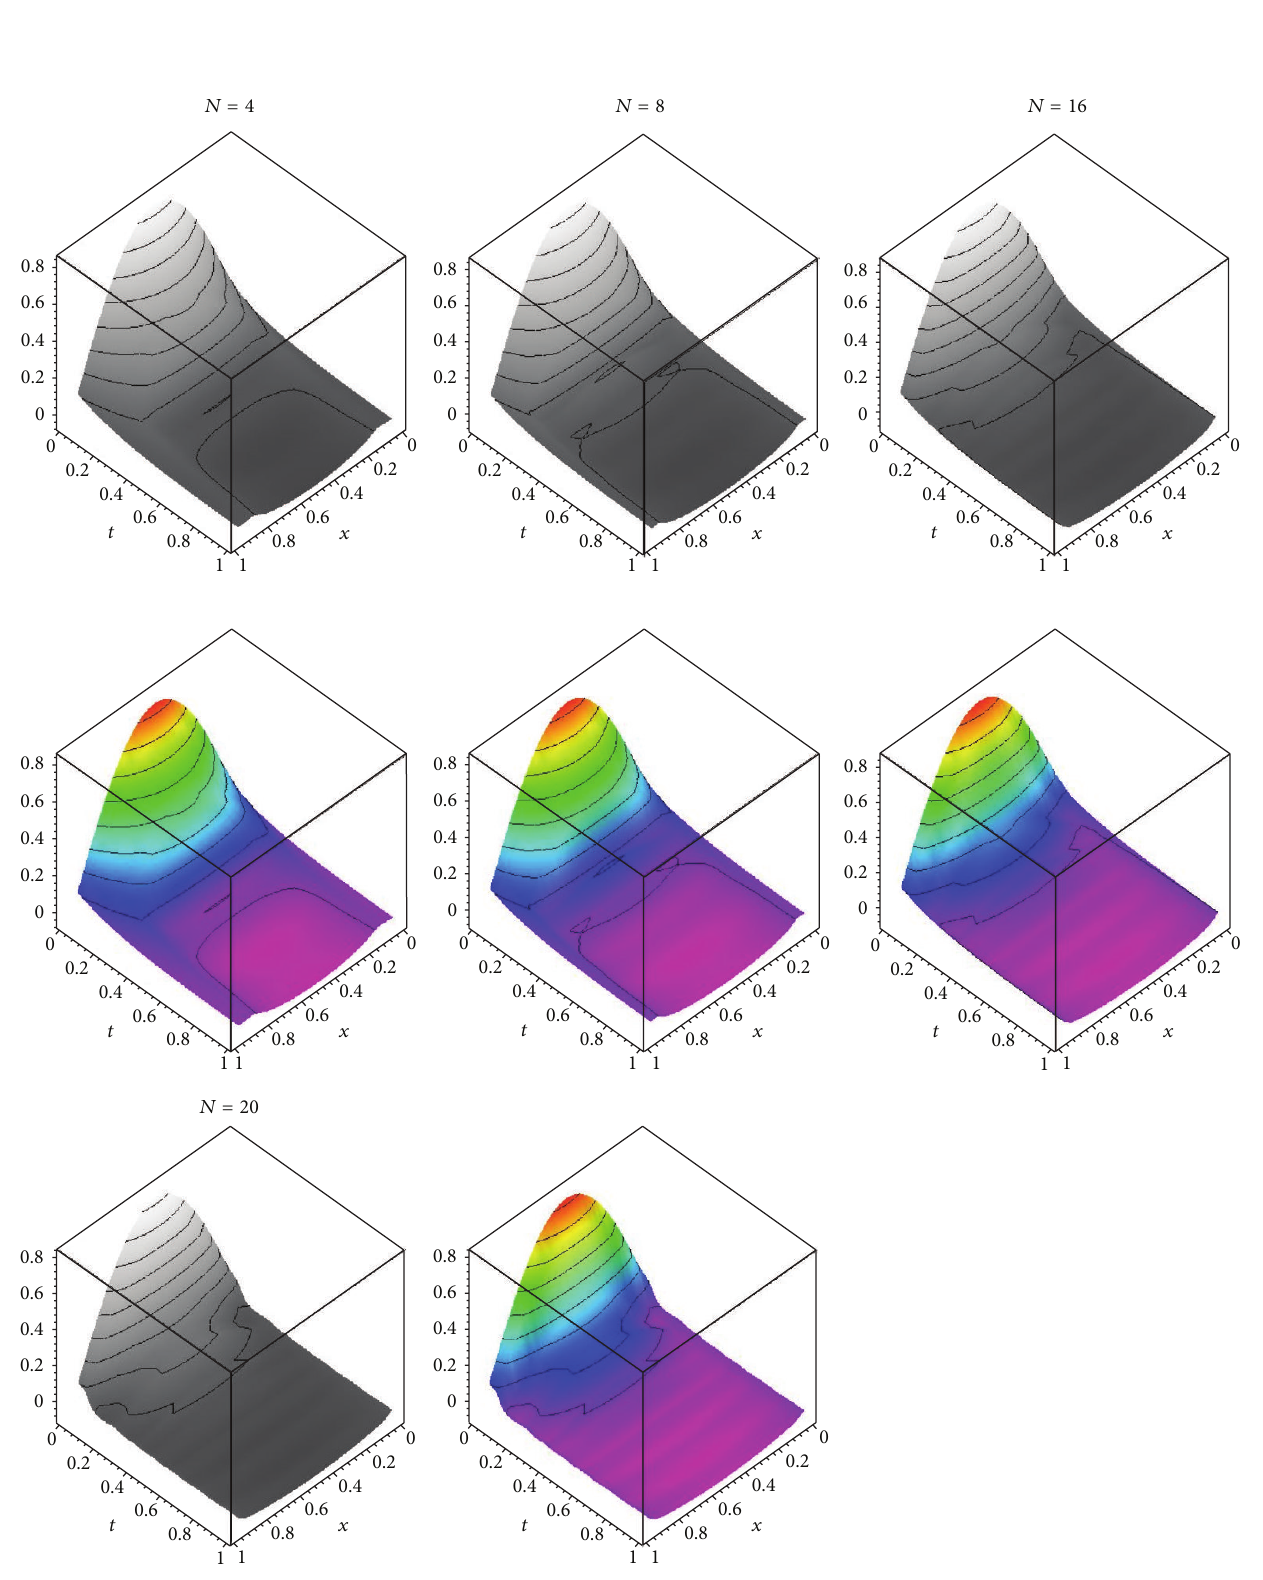
(a) The sinc-Galerkin solutions according to the grid points size